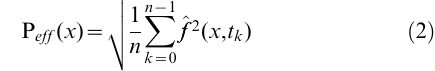
The age and the sex of each recorded individual, the number of orally and nasally emitted rumbles (and the percentage of those recorded in each context, respectively), and the mean duration, mean fundamental frequency, mean formant frequency values 1 and 2, and mean sound pressure level (SPL) 6 SD of rumbles per individual are presented. The estimated vocal tract length (VTL) for each individual based on the spacing in Hz between formants 1 and 2 for nasal and oral rumbles is also given. doi:10.1371/journal.pone.0048907.t001 The time function e of a point x= (x 9 , y 9 , z 9 ) T on the image plane was reconstructed by delay-and-sum beamforming [37] according to equation 1. Here, t denotes time, M is the number of microphones in the array, the w i are (optional) shading weights, the f i are the recorded time functions of the individual microphones, and the D i are the appropriate relative time delays, calculated from the absolute run times p i as D i = p i 2 min ( p i ). The absolute run times are determined by p i = | r i |/v, where v is the speed of sound in air and | r i | is the geometrical distance from microphone number i to the point of interest x . table. In equation 2, n is the total number of discrete time samples taken into account in estimating the effective value, e is the reconstructed time function of equation 1 of the sound pressure at location x , and t k is the time value at a discrete sample index k .